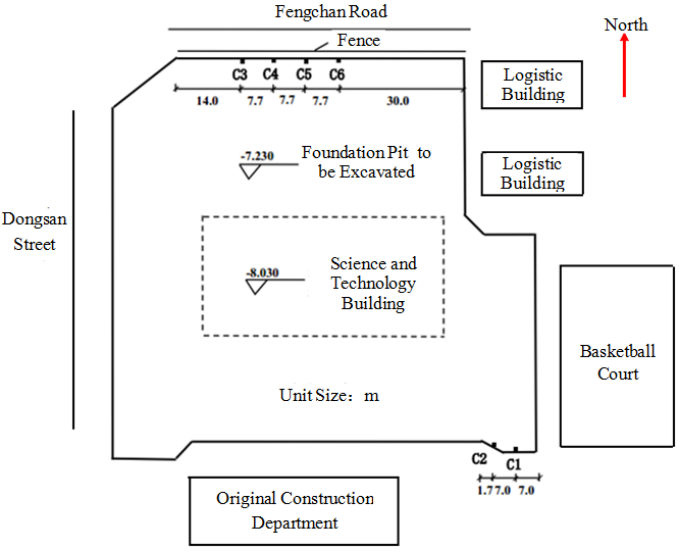
Figure 2. The layout of the foundation pit.